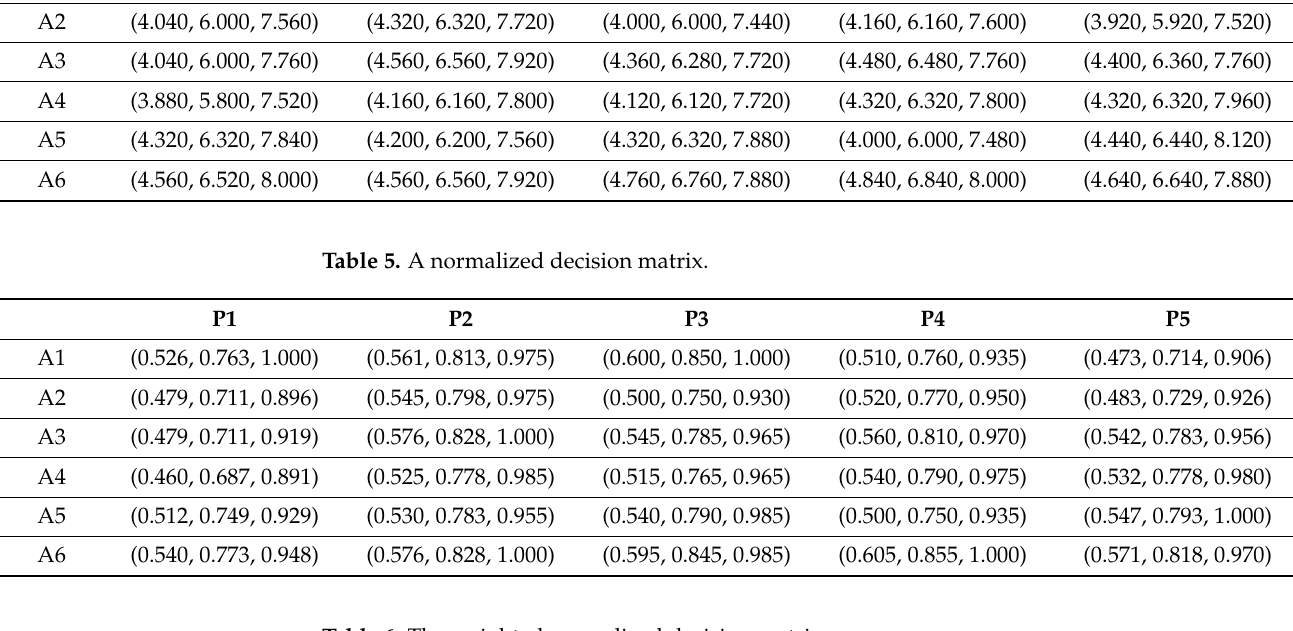
Table 6. The weighted normalized decision matrix.